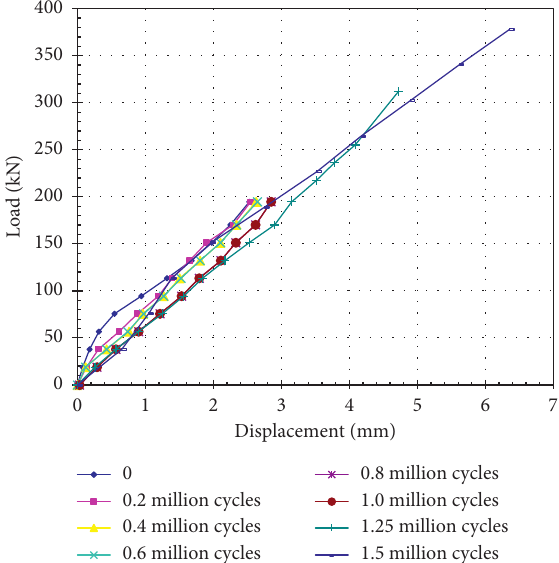
Figure 23: Comparison of midspan load-displacement curves (after dynamic loading of PLG-2).